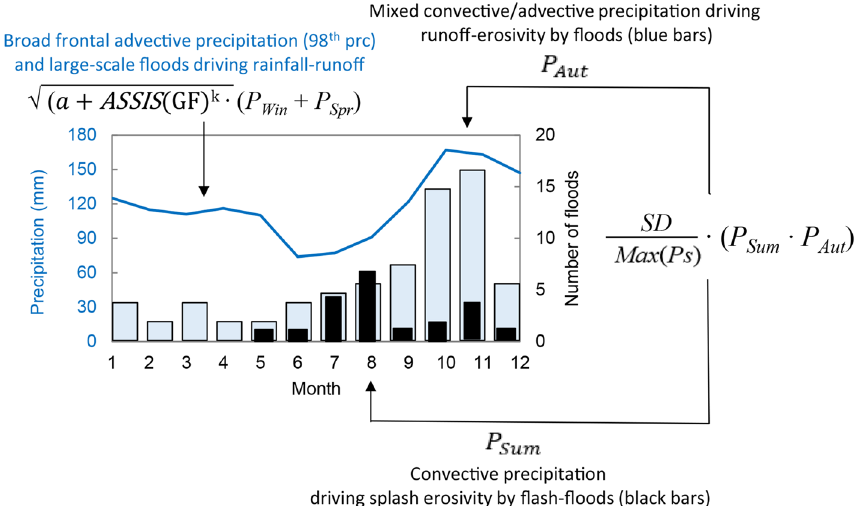
Figure 7. Monthly precipitation (98th percentiles) and frequency of floods and flash-floods (bars) driven by dominating frontal, convective or advective-convective rainfall events over the Mediterranean basin. The number of monthly floods (blue bars) and flash-floods (black bars) is from Guzzetti et al. 101 , Gaume et al. 102 and Diodato et al. 103 for the period 1950–2006. For the same period, monthly percentiles (prc) were extracted from the CRU Global Climate Dataset 104 . The terms of Eq. (1) are